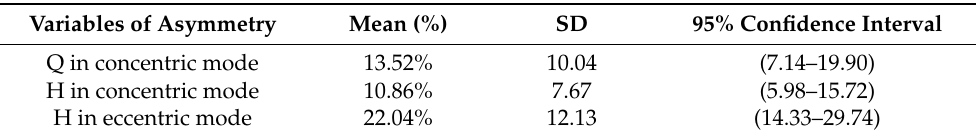
Table 2. Bilateral strength asymmetry (%) of quadriceps (Q) and hamstring (H) muscles in under 73 kg